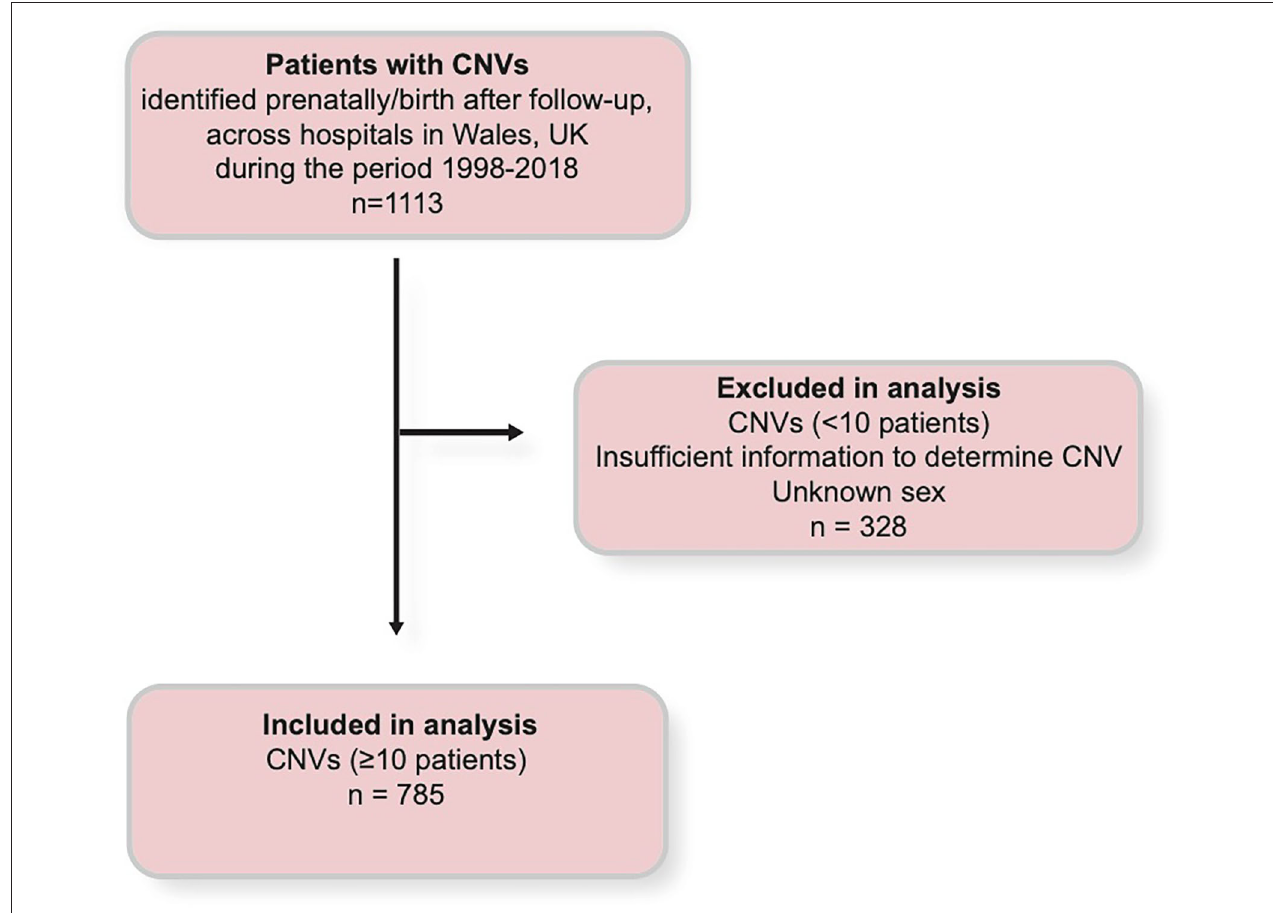
FIGURE 1 | Chart illustration of the selection criteria by which data was obtained and used, and by which data was excluded during analysis. CNV, copy number variant.